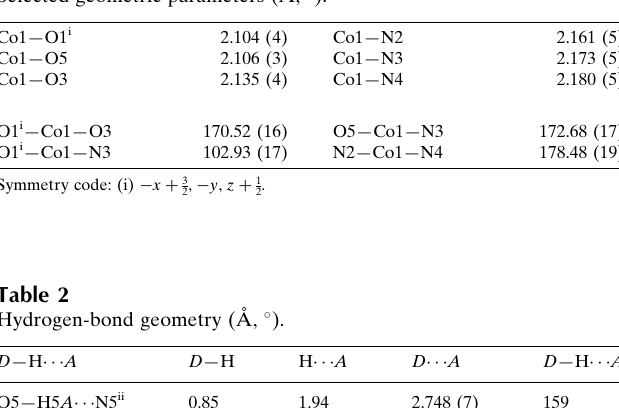
Selected geometric parameters (A˚ , (cid:4) ).